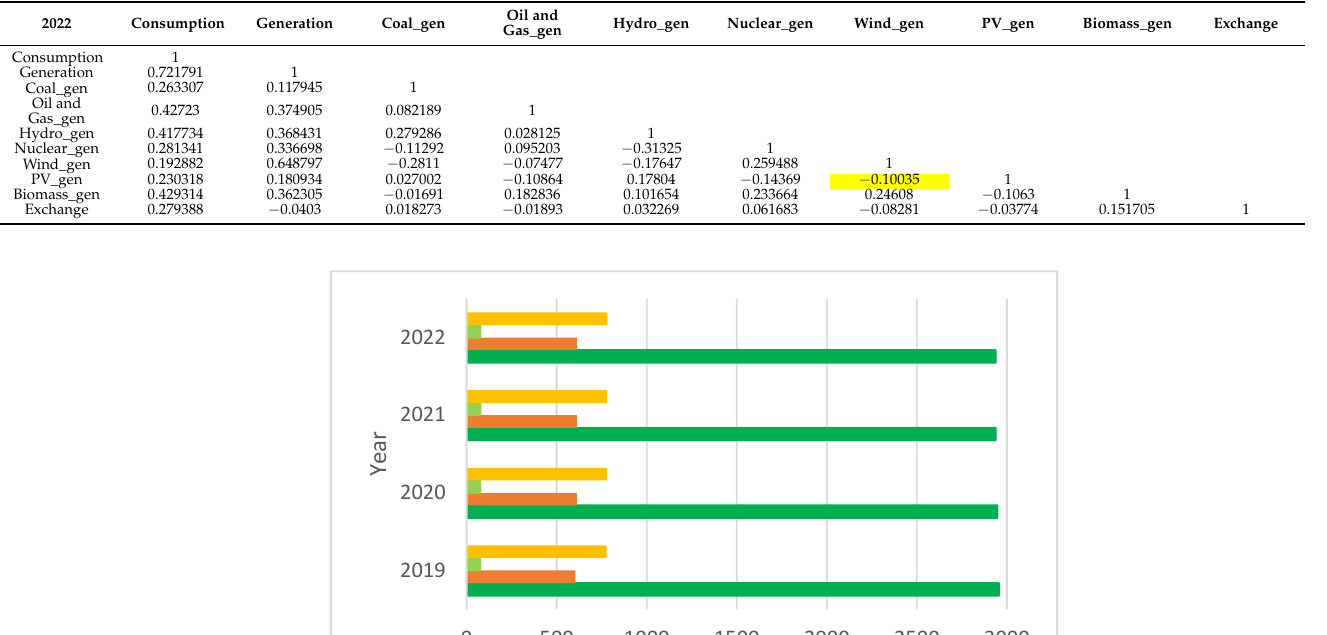
Table 4. Correlation coefficients between consumption and generation sources in 2022.